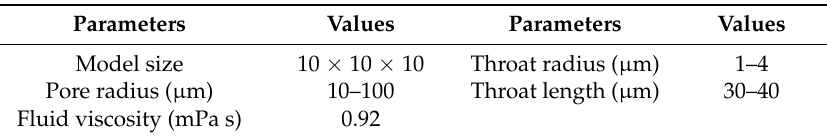
Table 3. Parameters of pore scale network model.